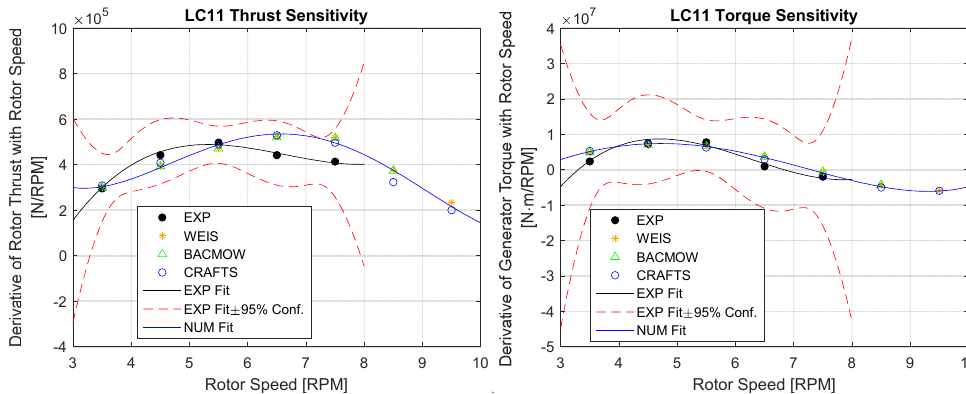
Figure 4. LC 1.1 sensitivities of thrust and torque with respect to rotor speed ( left and right , respectively).